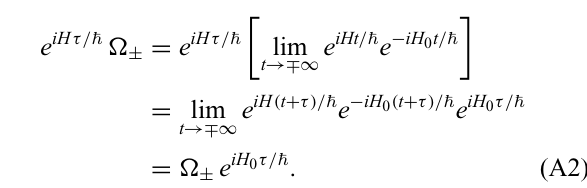
Fig. 6 will thermalize the system to the temperature of the ensemble β if the level spacing (cid:8) is large enough. One Y can even induce a crossover from narrow to broad wave packets by decreasing (cid:8) Y